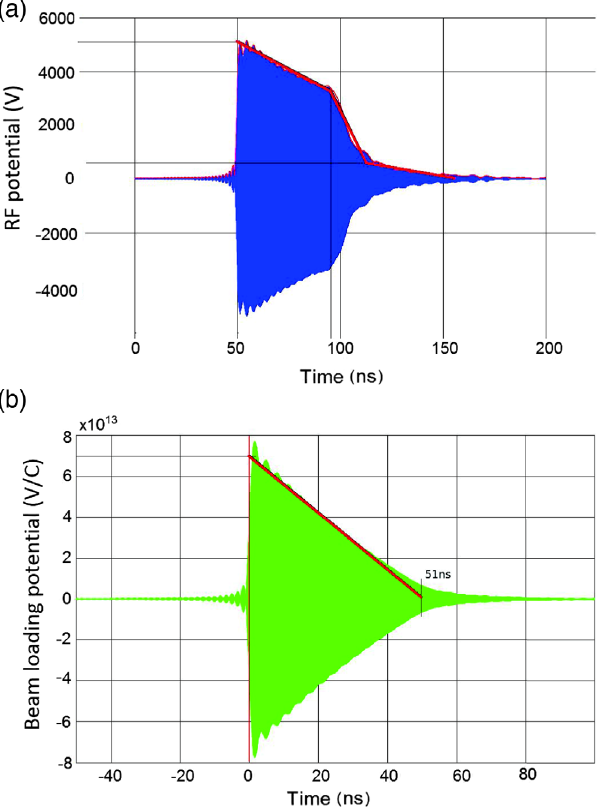
FIG. 10. Simulation result for rf filling potential (a) and beam loading amplitude (b) as a function of time for CLIC main beam accelerating structures [3]. Approximations by linear functions are indicated by the red